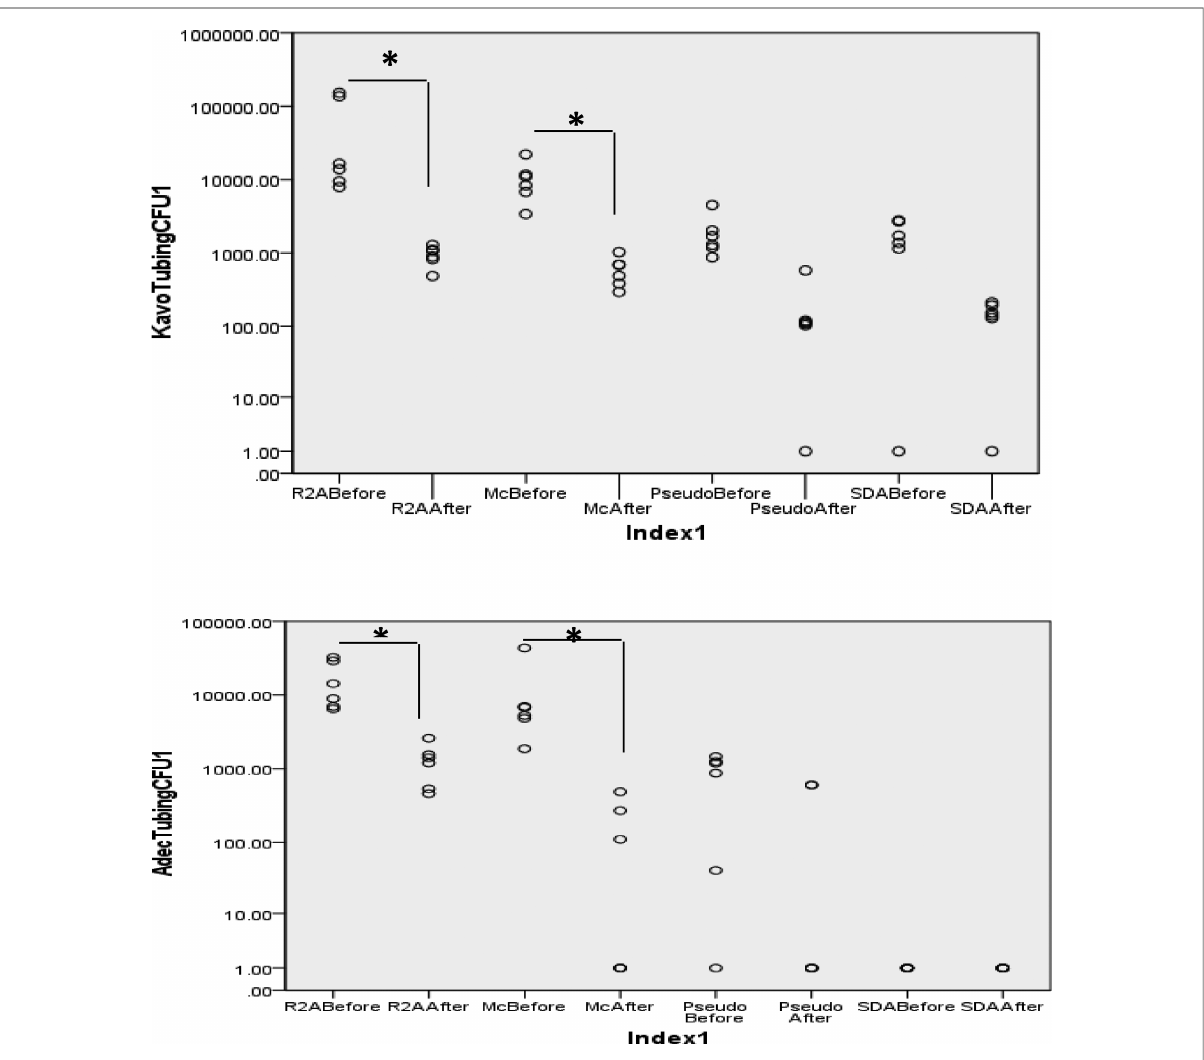
FIGURE 4 Bacterial counts from the bio fi lm harvested from DUWL tubing before and after treatment. Bio fi lm was scraped off the tubing surface using sterile dental probe and suspended in sterile PBS. Serial 10-fold dilutions (up to 10 − 5 ) were prepared and plated on different culture media. P <0.05 Mann Whitney